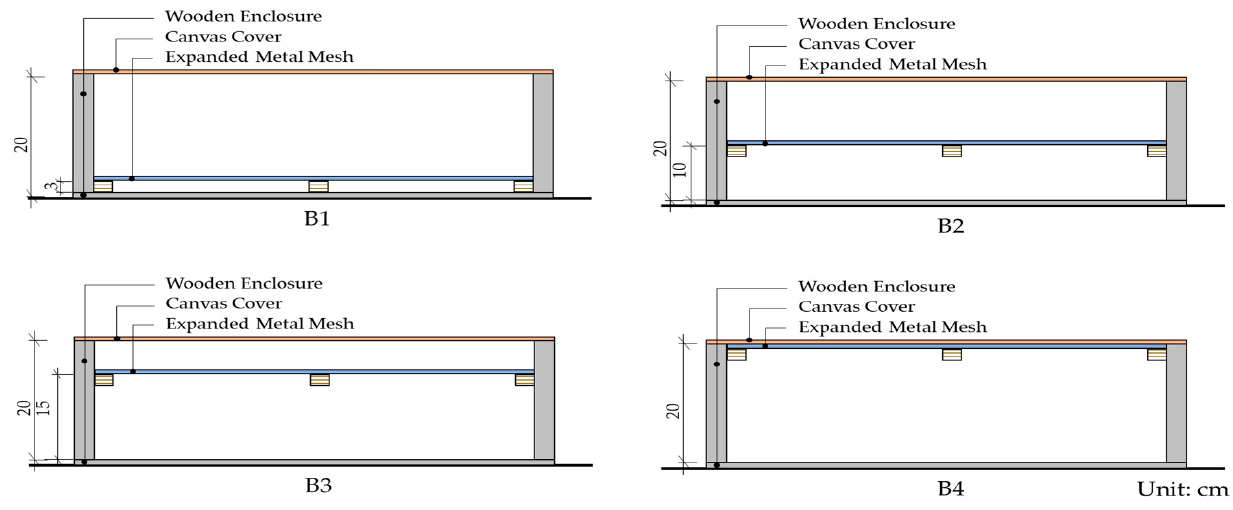
Figure 4. Group A section in stage 2, as table2.